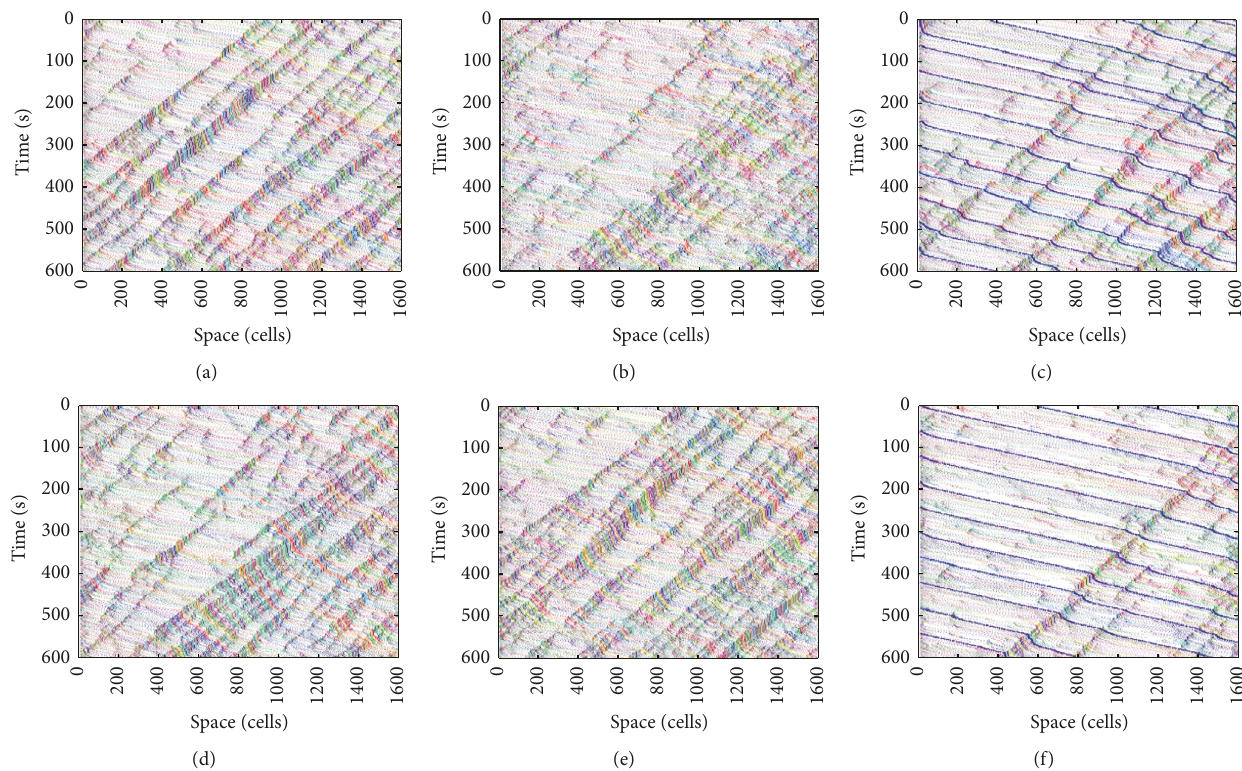
Figure 2: Time-space distributions of Case A (a, b, c) and Case B (d, e, f). (a) Time-space distribution of the left lane in Case A. (b) Time- space distribution of the middle lane in Case A. (c) Time-space distribution of the right lane in Case A. (d) Time-space distribution of the left lane in Case B. (e) Time-space distribution of the middle lane in Case B. (f) Time-space distribution of the right lane in Case B.